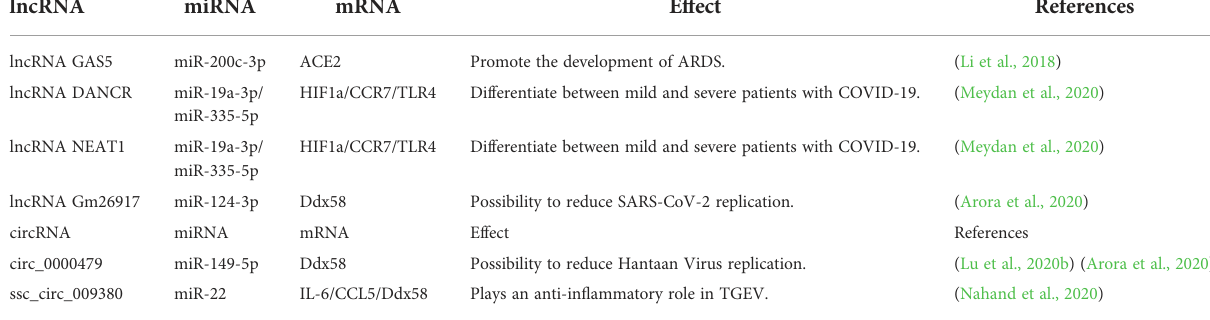
TABLE 2 The impact of ceRNA in